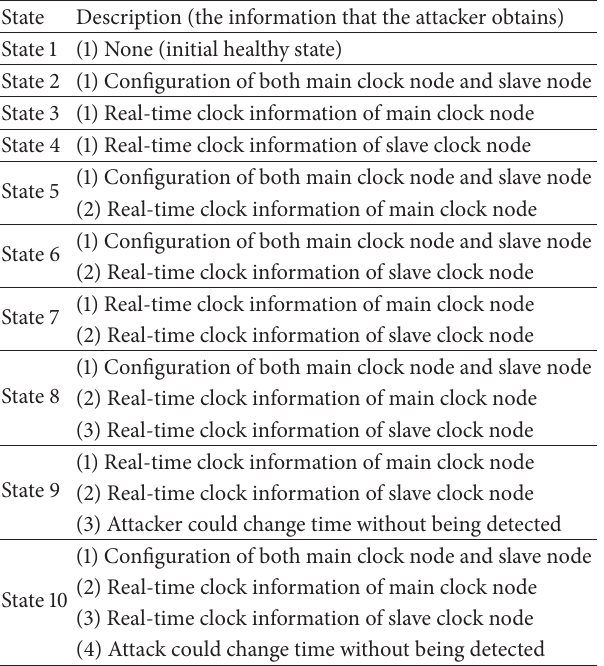
Table 2: The description of states. Table 3: Optimal strategies for rational